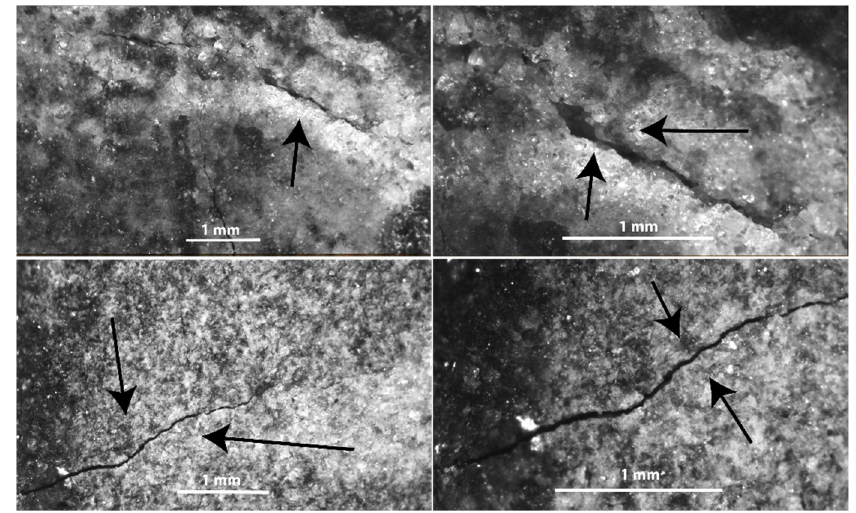
Figure 6. Fracture generation in samples thermally treated to 1000 °C .